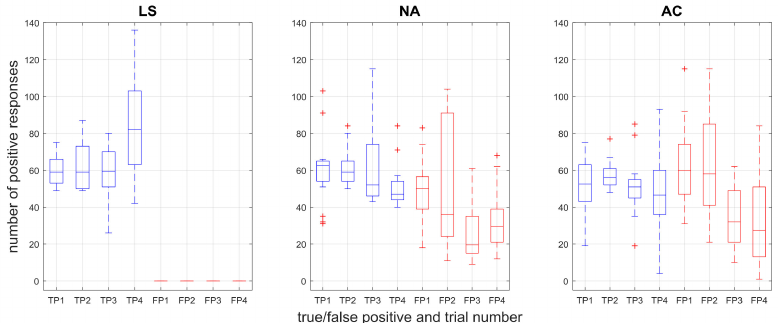
Figure 6. Number of true positive (TP) and false positive (FP) responses across test trials for the three